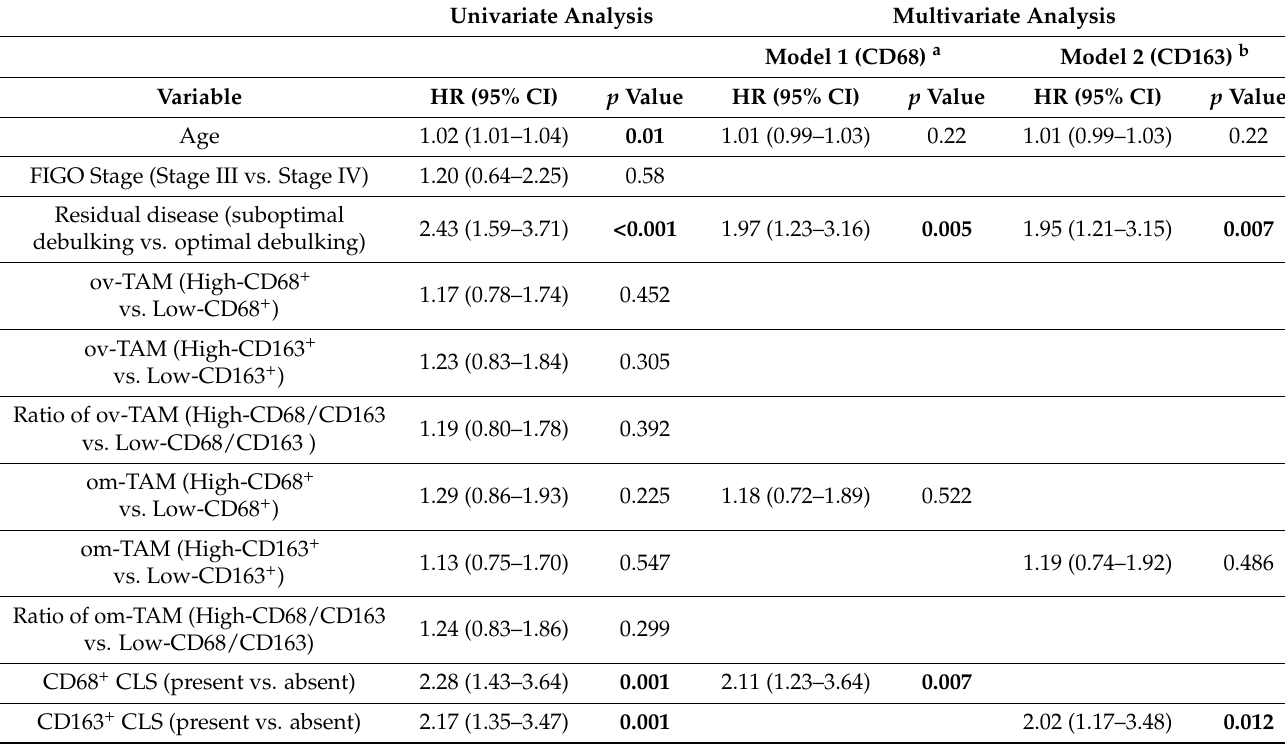
Table 3. Univariate and multivariate Cox proportional hazards regression model for progression-free survival ( n = 116). Univariate Analysis Multivariate